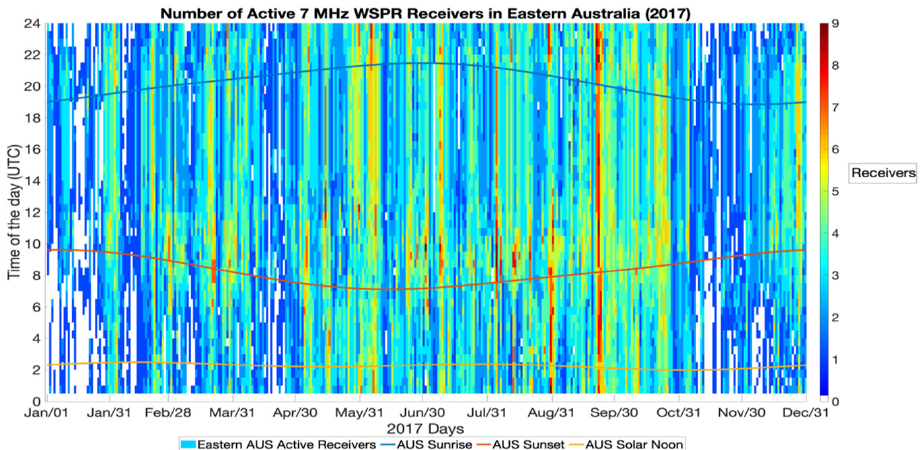
Figure 11. Number of active Eastern Australia WSPR receivers in 2017. Only receivers with a proven capability to cover the distance from the UK to Eastern Australia are shown. The colours indicate the number of receivers available in each half-hour interval.